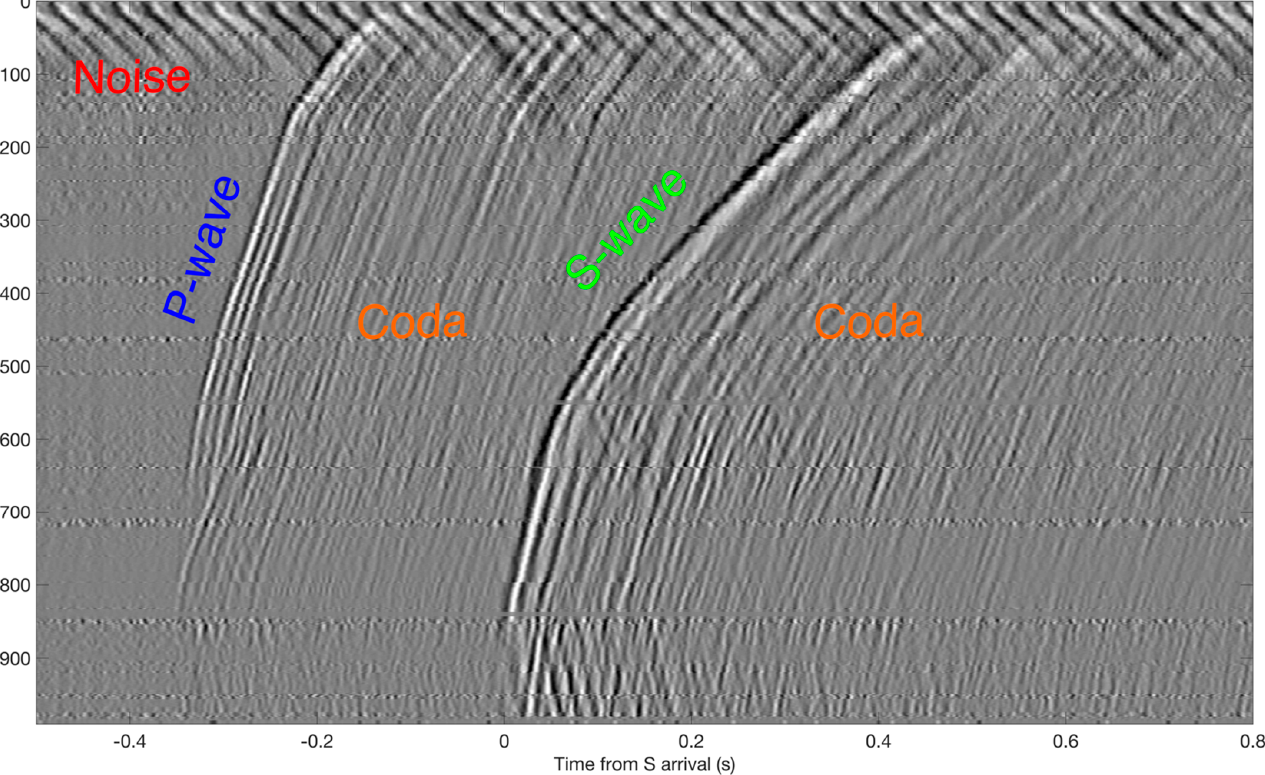
Figure 11. Earthquake recorded by vertical DAS. It shows clear P (annotated in blue) and S arrivals (green), as well as trailing coda events (orange). First arrivals have a refraction-like behavior, as the energy dissipates quickly below a depth of ~840m. High levels of noise (red) in the near-surface are visible, illustrating the benefits of downhole recording. Adapted from Lellouch et al. (2021), Journal of Geophysical Research: Solid Earth.